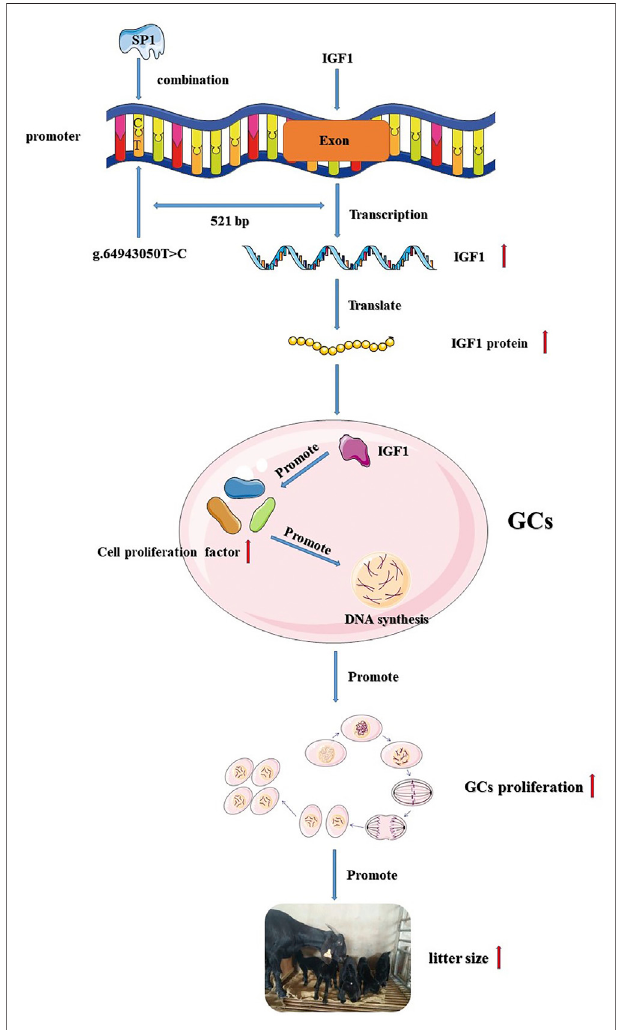
FIGURE 6 | Flow chart of the IGF1 g.64943050T > C mutation regulating goat reproduction through the transcription factor SP1.